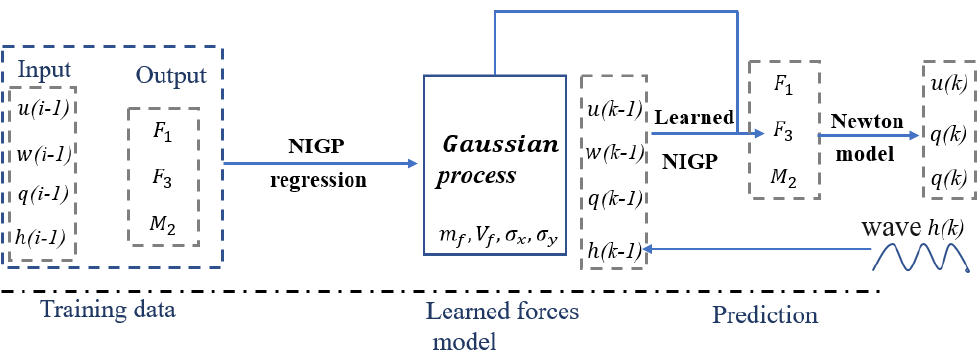
Figure 7. Process of nonparametric gray-box modeling of the WEC using NIGP.